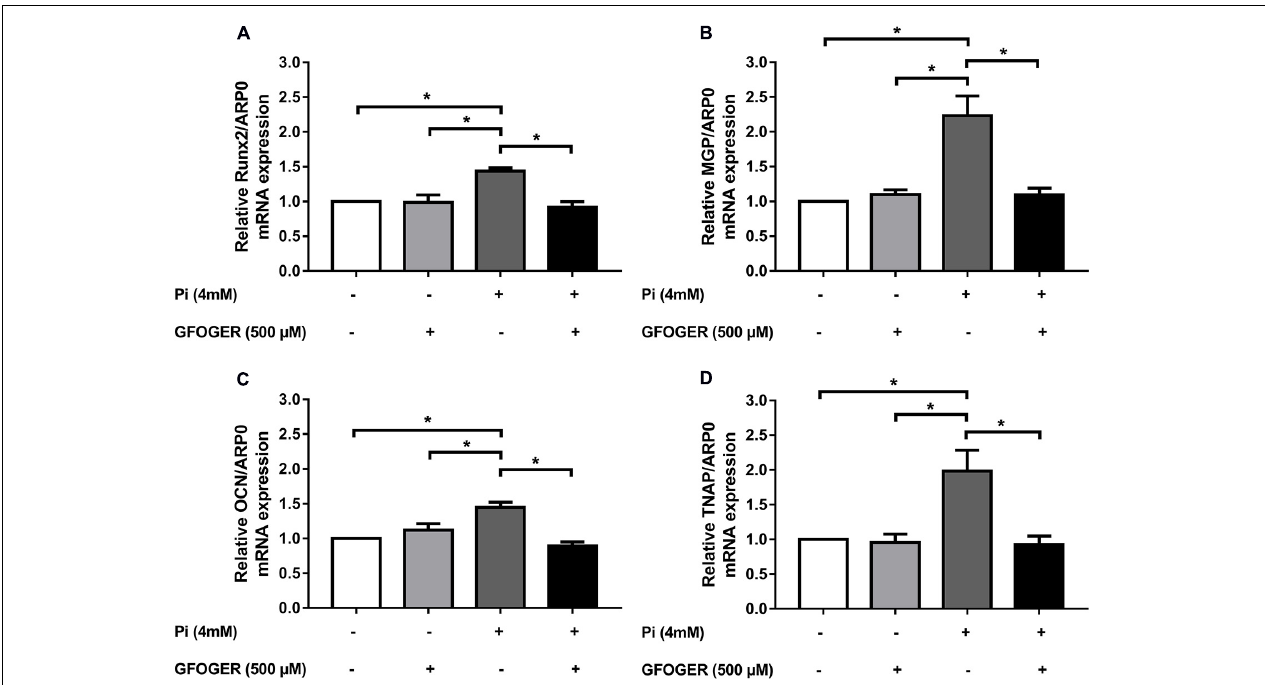
FIGURE 5 | GFOGER peptide decreases the expression of osteogenic markers such as Runx2, MGP, OCN, and TNAP. MOVAS-1 cells were incubated with 500 µ M GFOGER peptide in the presence or absence of 4 mM Pi for 8 days. Gene expression of different osteogenic markers was then quantified by RT-qPCR and normalized to the housekeeping gene ARP0. (A) Runx2, (B) MGP, (C) OCN, and (D) TNAP. Data are expressed as mean ± SEM of four independent experiments done in triplicate ( n = 4). * p < 0.05 vs. 4 mM Pi; Mann–Whitney